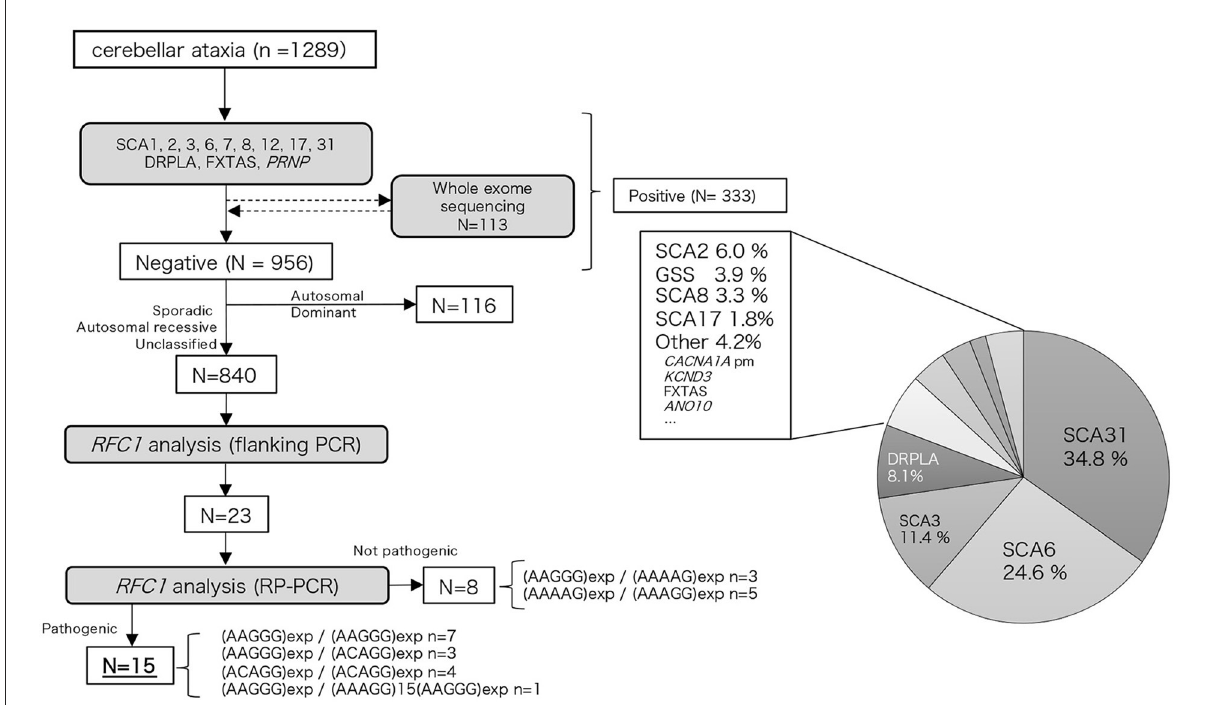
FIGURE1 Flow chart of our study. We performed hereditary ataxia-related gene analysis for 1,289 cerebellar ataxia cases. Of the 956 cases that tested negative, 840 cases were analyzed for the RFC1 repeat expansion.